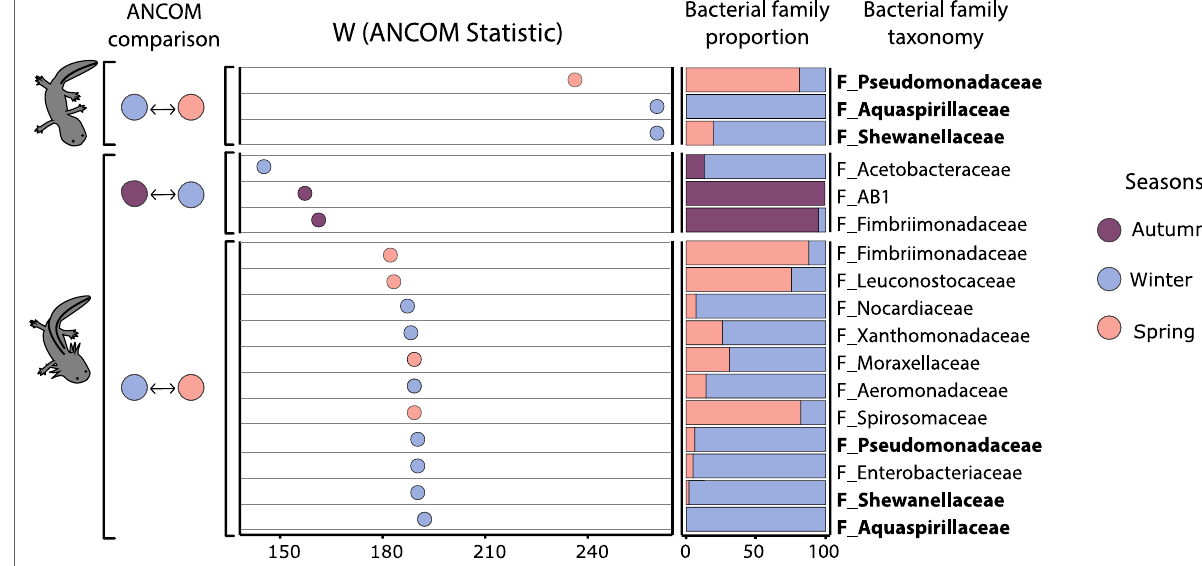
Fig. 4 ANCOM results showing differentially abundant bacterial families in metamorphic and pre‑metamorphic axolotls across consecutive seasons: autumn to winter seasons in pre‑metamorphic axolotls, and winter to spring seasons for metamorphic and pre‑metamorphic axolotls. From left to right: ANCOM comparisons color‑coded by season, ANCOM W values, the relative bacterial family proportion and the best taxonomic assignment according to SILVA at order (O), class (C) or family (F) level. Circles and bars are color‑coded by season. Shared bacterial families between metamorphic and pre‑metamorphic axolotls between winter and spring seasons are shown in